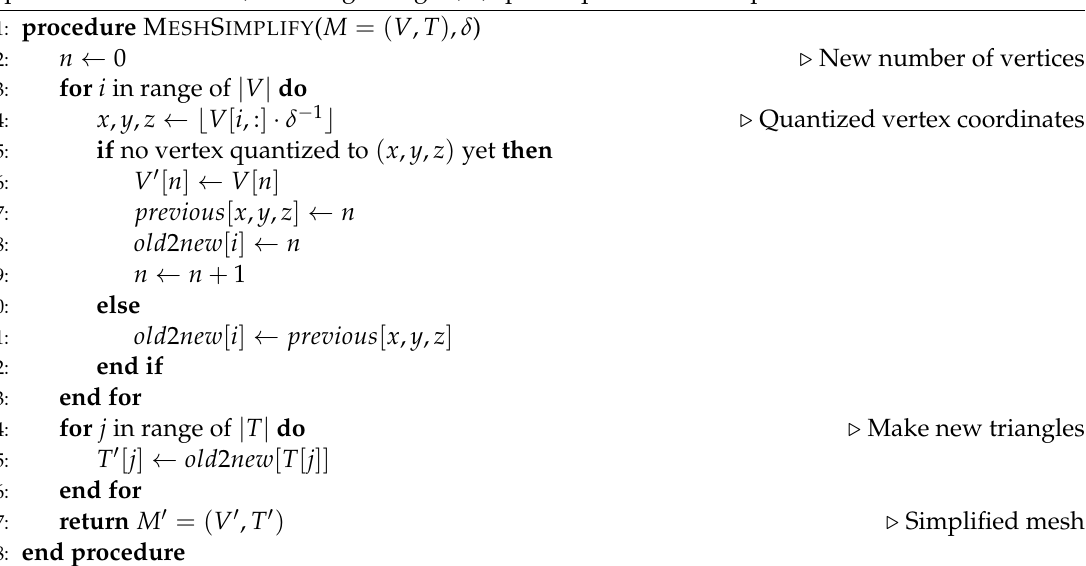
Algorithm 1 Mesh simplification algorithm. Requires: V , array of 3-D vertices; T , concatenation of triplets of vertex indices, denoting triangles; δ , spatial quantization